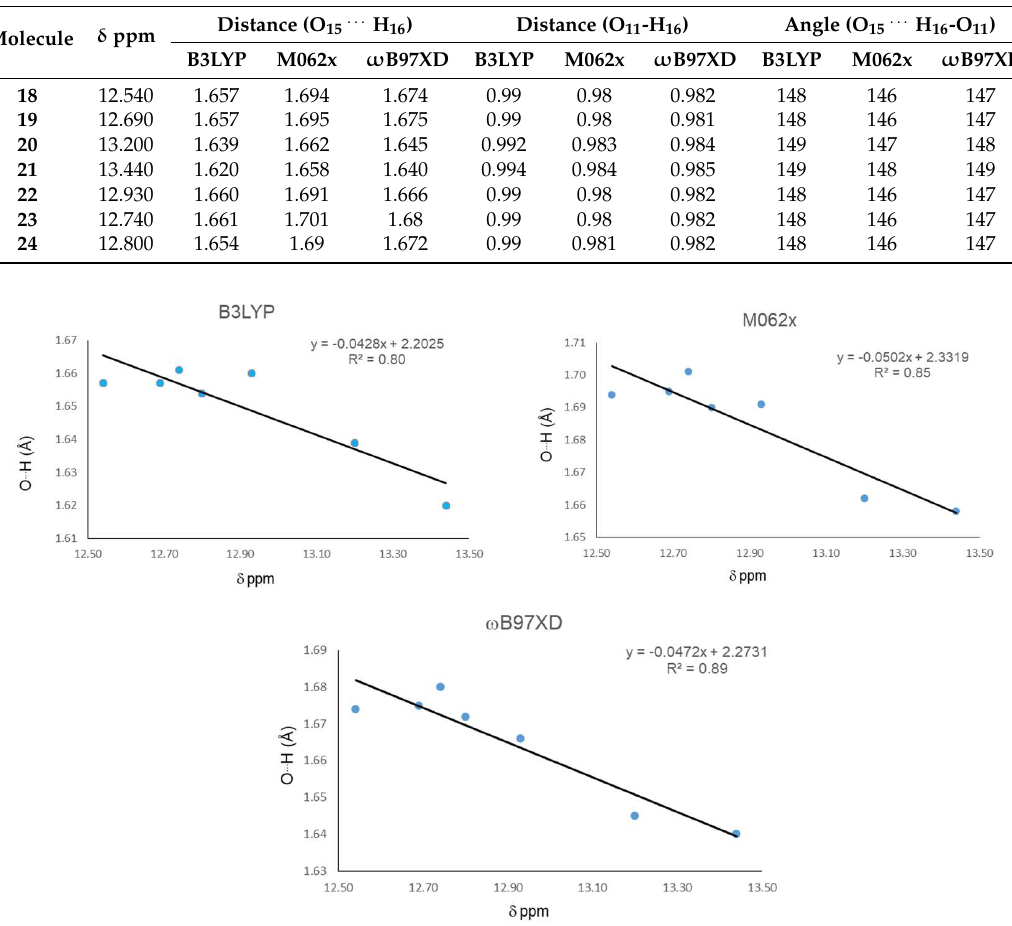
Table 1. Experimental chemical shifts (δ) in ppm of protons involved in hydrogen bonding, and main geometric calculated parameters. Distances in angström, (Å), and angles in degree (°).